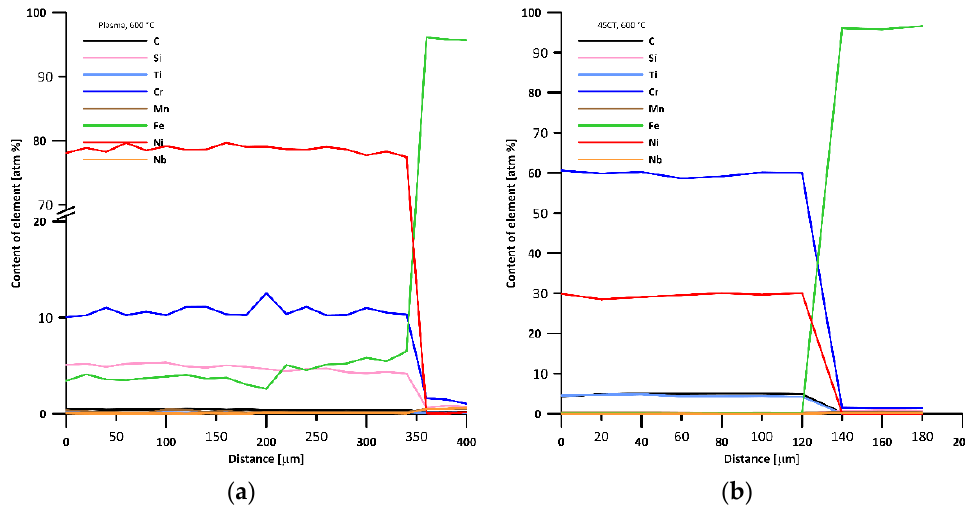
Figure 13. ( a ) Chemical analysis of the coatings performed by EMPA with 20 μ m steps (each point is the average of 10 separate measurements). ( a ) Plasma; ( b ) TWAS—45CT4.